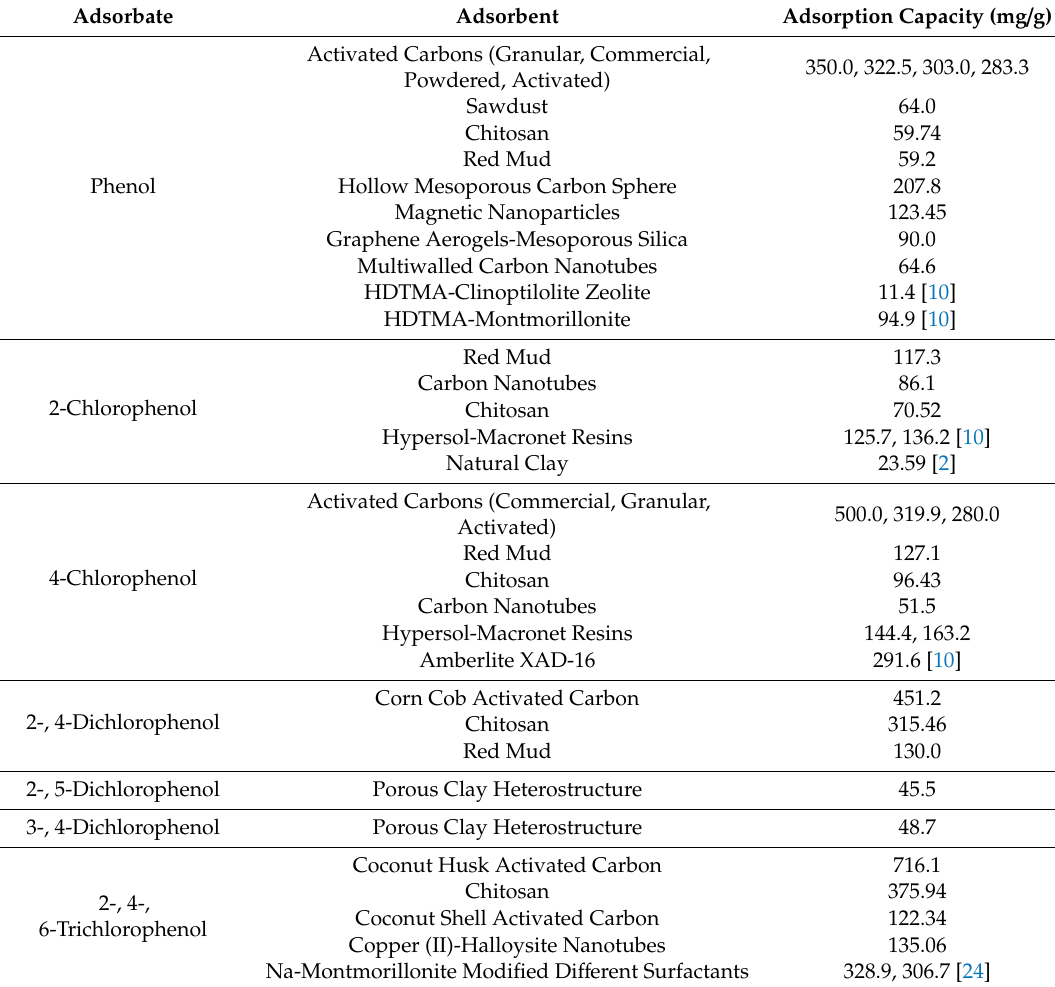
Table 1. Adsorption capacity of various adsorbents for phenol and its chloro derivatives